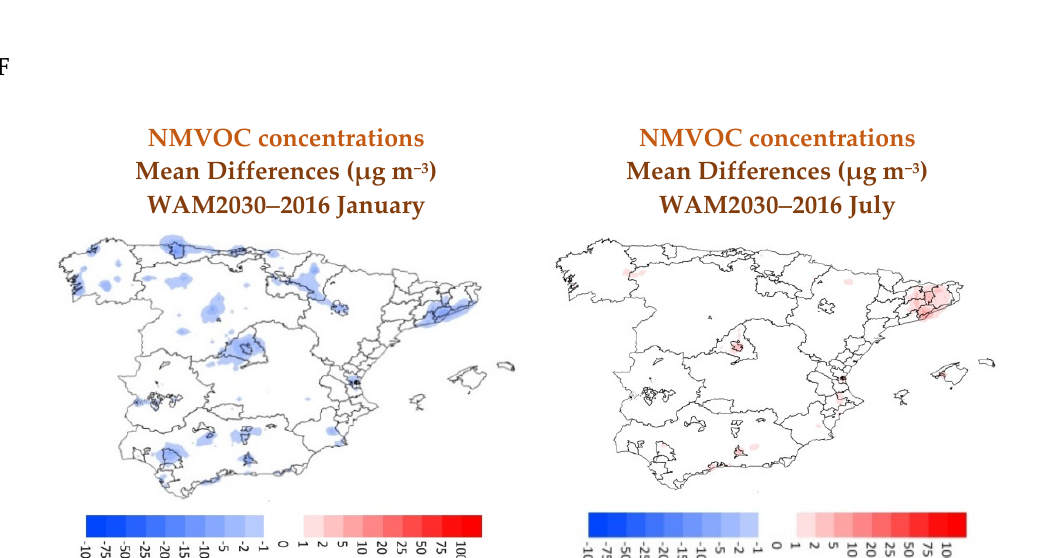
Figure A5. Relative differences (%) of annual NO x (left) and NMVOC (right) emissions between the WAM2030 scenario and 2016.